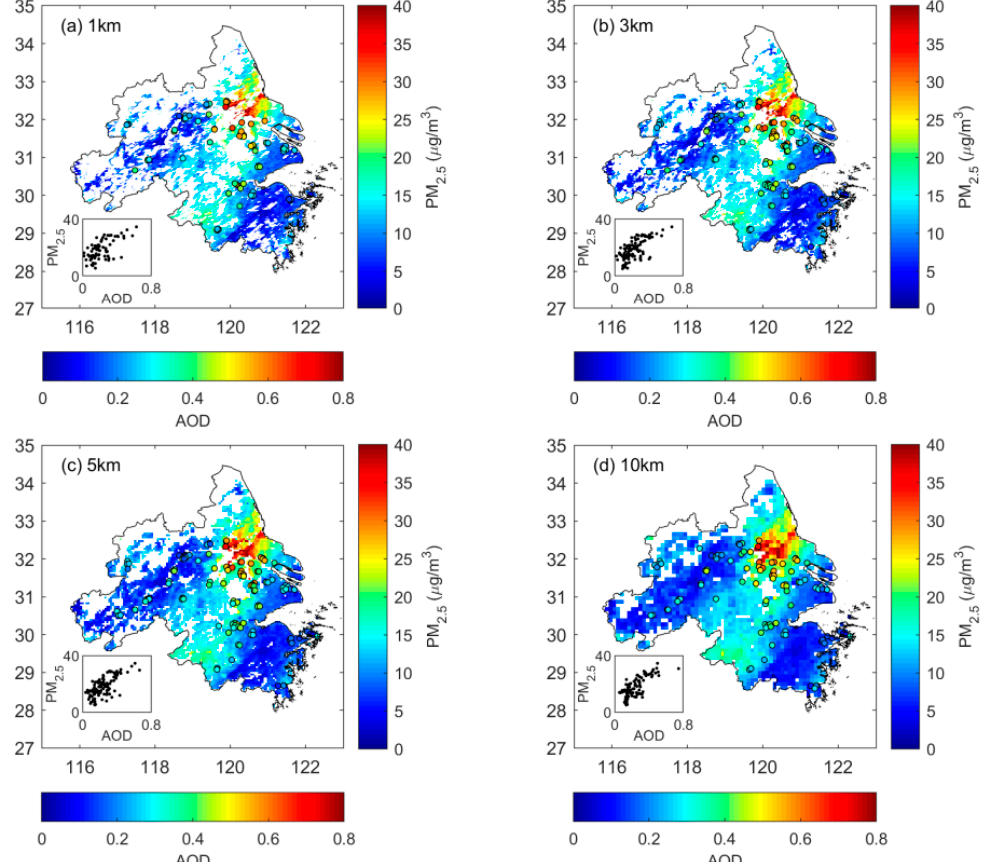
Figure 3. The spatial distributions of AOD and PM 2.5 concentration on 15 August 2020 at the resolutions of ( a ) 1, ( b ) 3, ( c ) 5 and ( d ) 10 km. The colored dots and background color represent PM 2.5 concentration and AOD, respectively. The inset in each panel is the scatterplot between PM 2.5 and AOD.